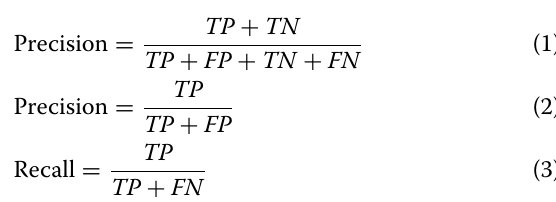
The accuracy, precision, and recall (as shown in Eqs. (1), (2), and (3)) are calculated the same as in [9].